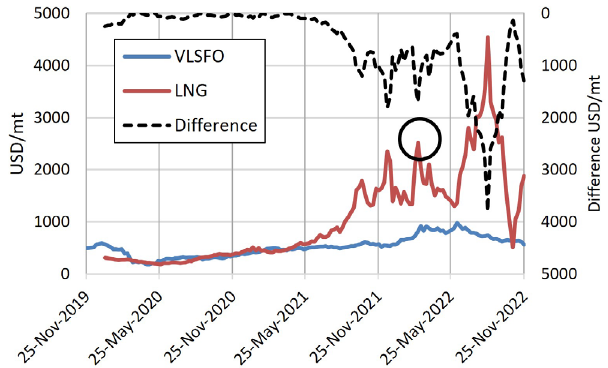
Figure 2. Price (USD$/mt) of VLSFO, LNG and the difference (right axis).